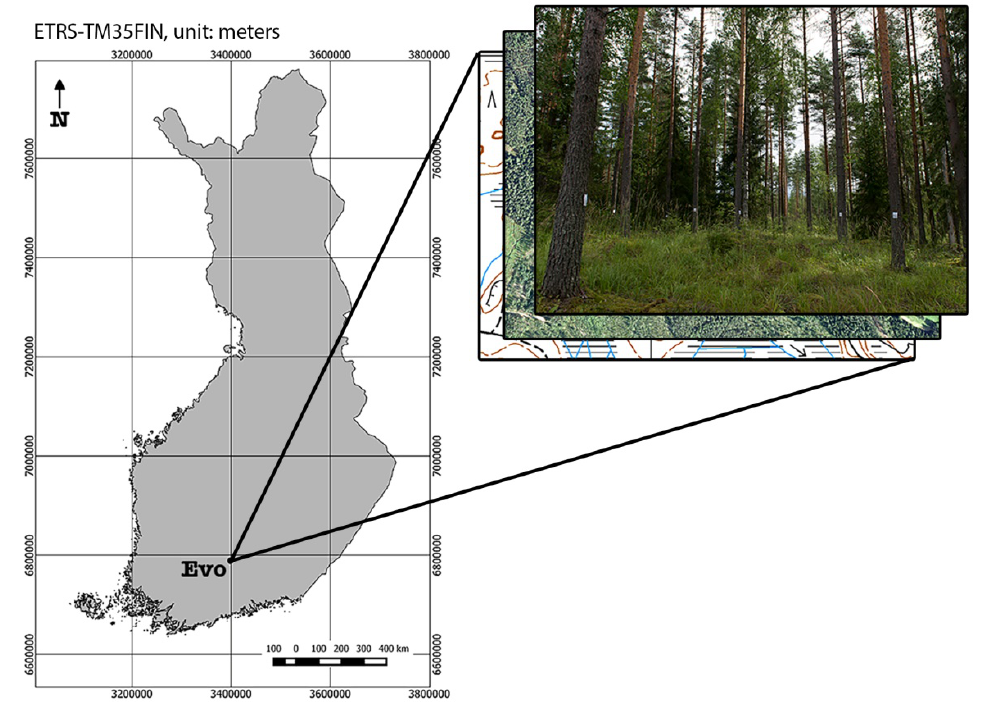
Table 1. Descriptive statistics of the field measurements. Abbreviations: diameter-at-breast height ( dbh ), tree height ( h ), diameter at 6-m height ( d and dead ( db ) branch and tree volume ( v